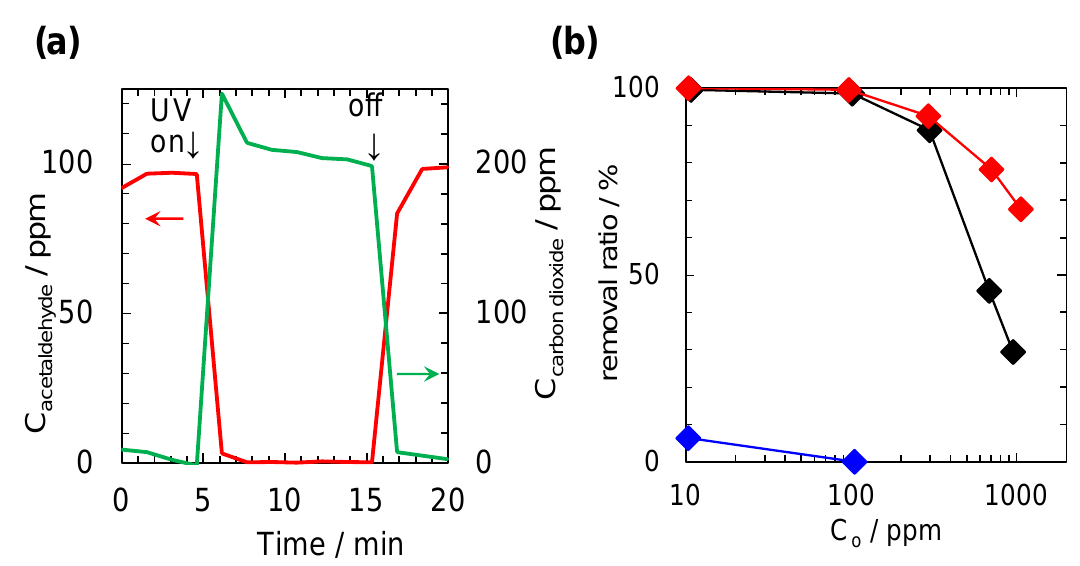
Figure 4. ( a ) Typical data set of acetaldehyde removal (red) and CO 2 generation (green) by the TiO 2 -impregnated a-silica tube with UV-C irradiation. ( b ) Removal ratio vs. initial concentration of acetaldehyde by the TiO 2 -impregnated a-silica tube (red), a-silica tube covered with TiO 2 /Ni-foam (black), TiO 2 -coated a-silica tube by the OVD method (blue).